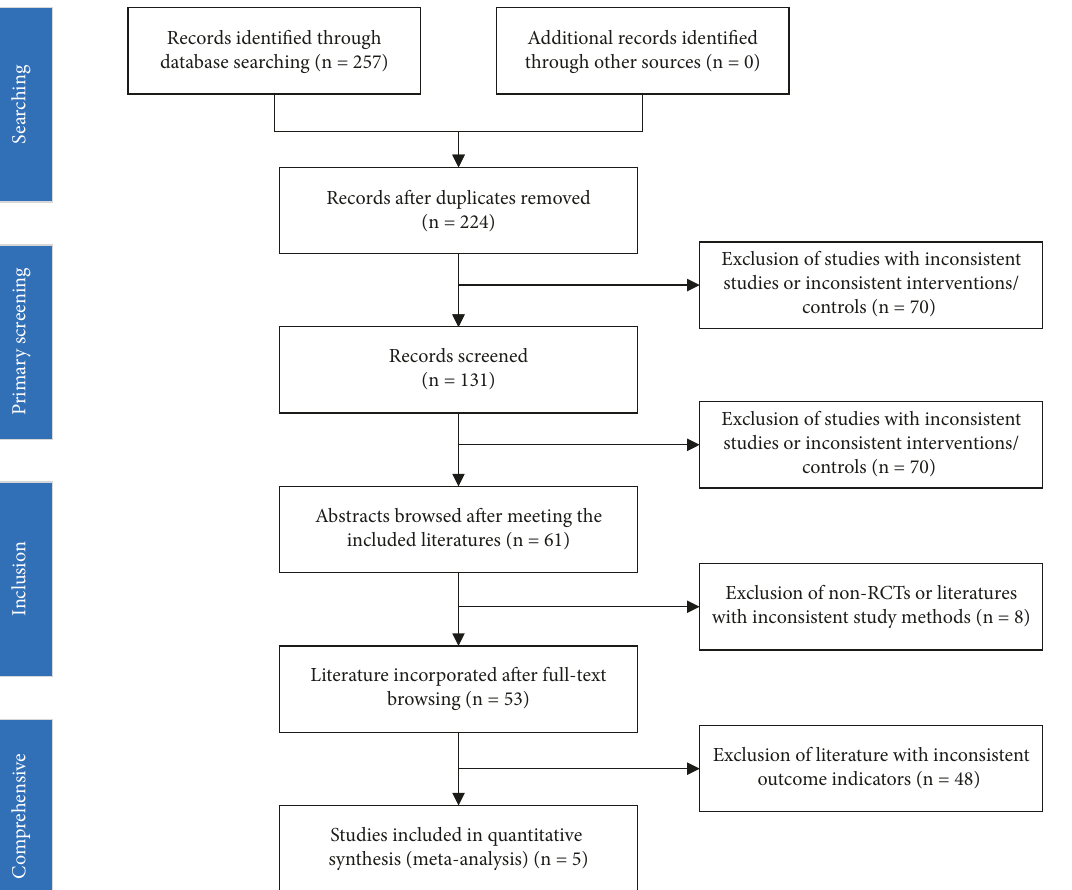
Figure 1: PRISMA diagram for the systematic